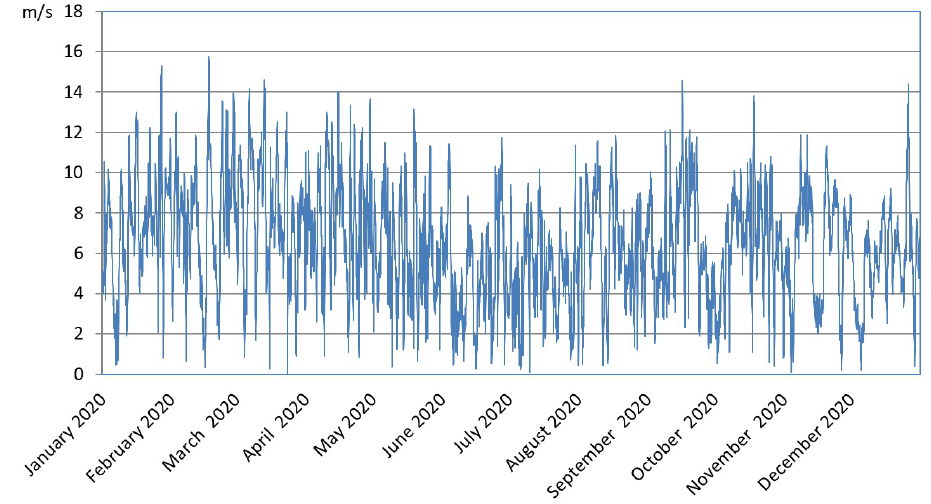
Figure 4. Distribution of wind speed in the wind farm zone at an altitude of 100